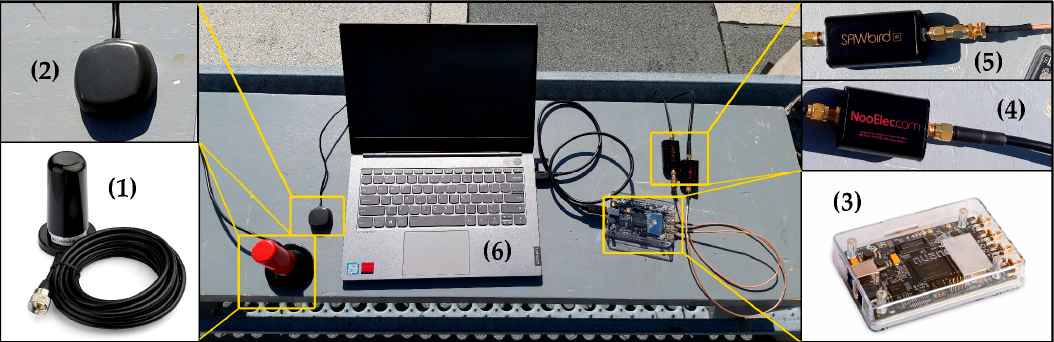
Figure 7. ( 1 ) Dual VHF/UHF antenna for Orbcomm constellation; ( 2 ) Iridium antenna; ( 3 ) BladeRF V2 SDR; ( 4 ) RF bandpass filter; ( 5 ) Low-Noise Amplifier (LNA) for Iridium frequency range; ( 6 ) PC.